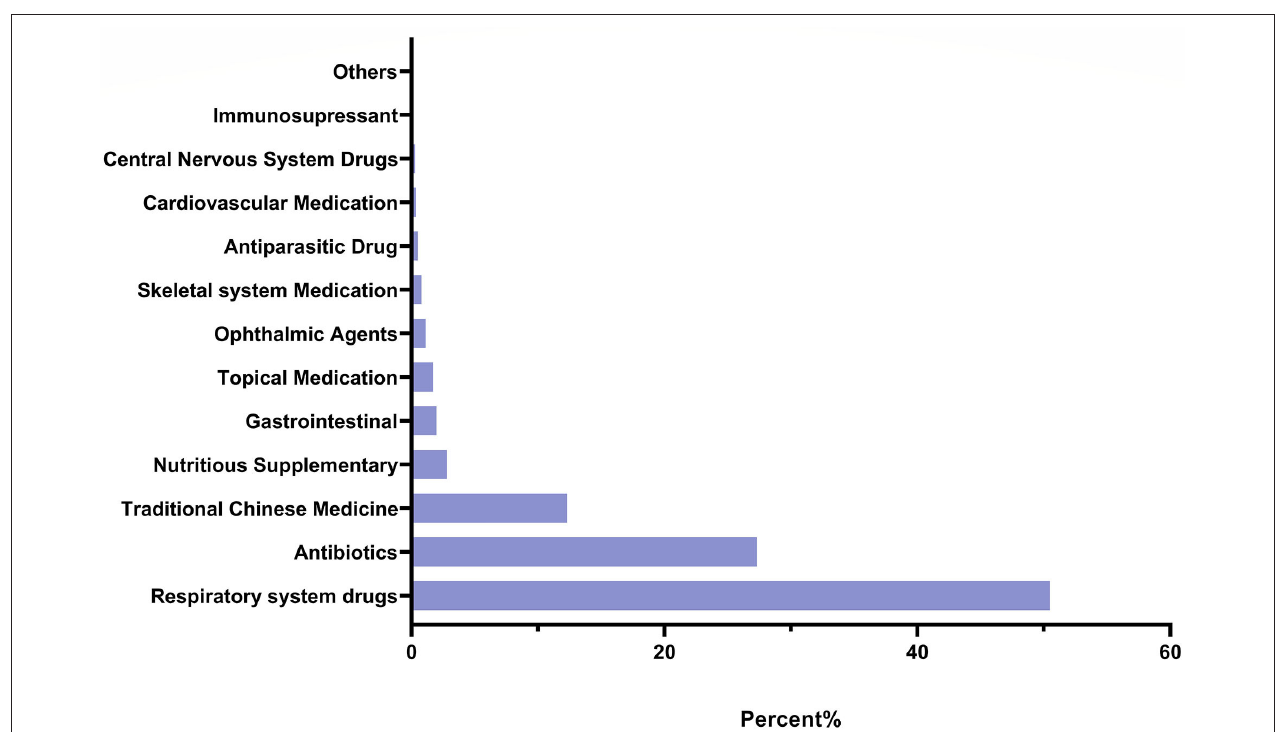
FIGURE 2 | Incidence (%) of prescription errors under the different medication